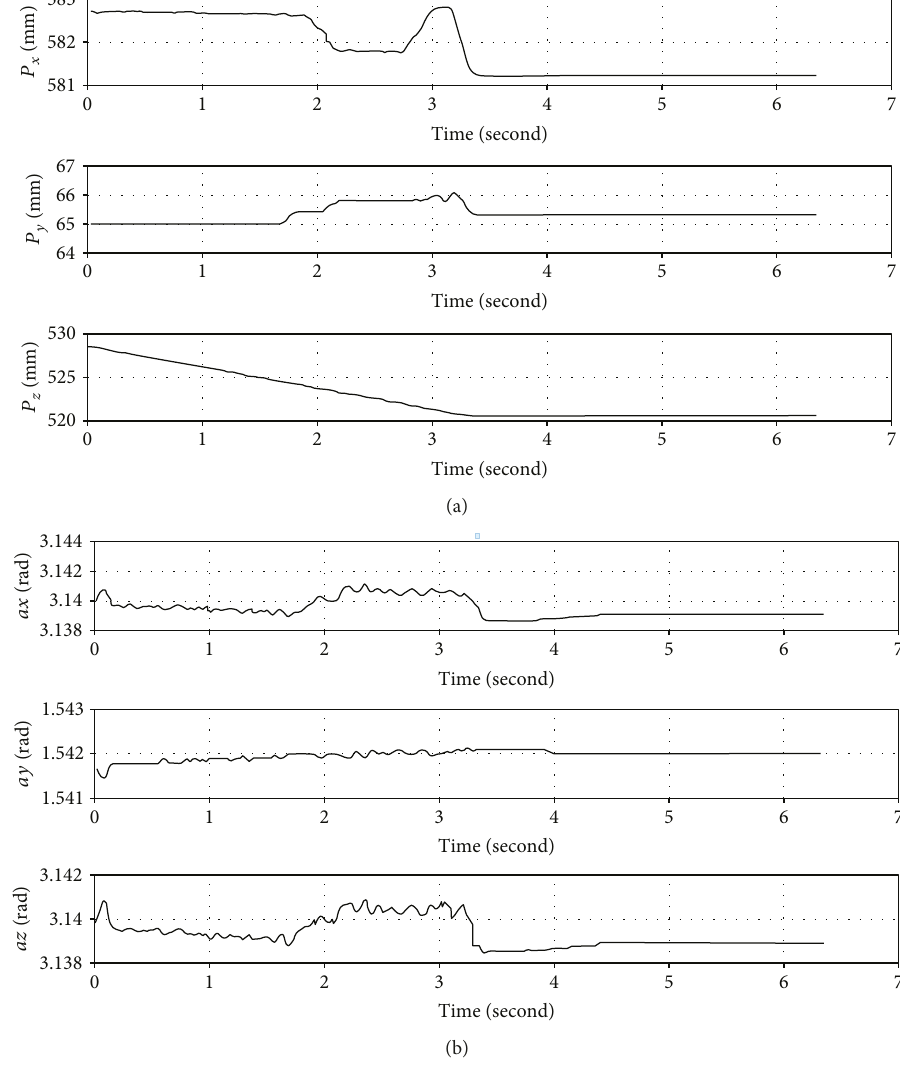
Figure 21: The end poses under impedance control: (a) position and (b)